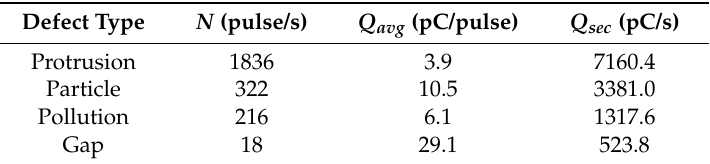
Table 2. N , Q avg , and Q sec of PD caused by four kinds of